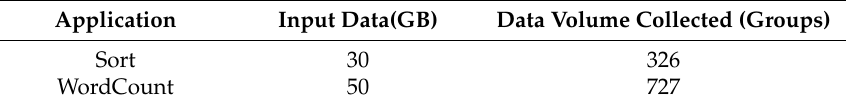
Table 2. The detailed volume of input data and collected data.